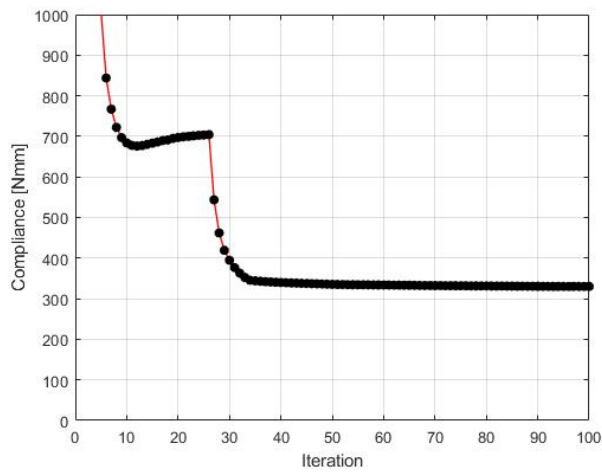
Figure 17. The compliance history for the test structure 3. Minimal value: 342.96 Nmm. Black dots on the red line represent the compliance values for subsequent iterations.